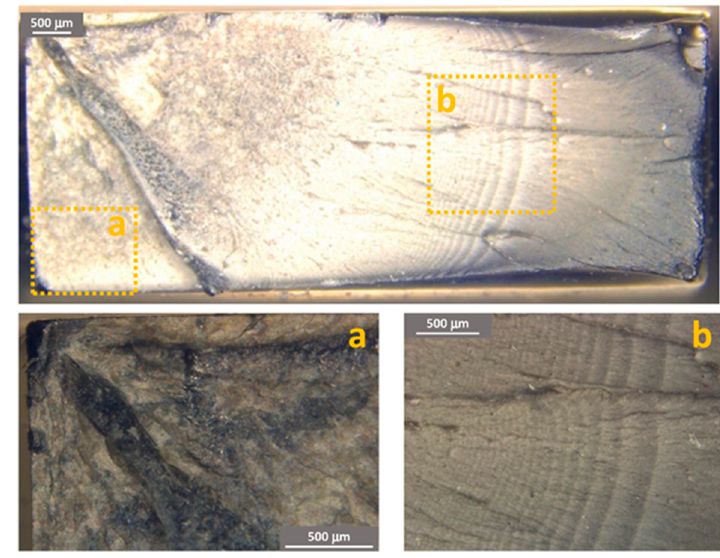
Figure 12. PC-ABS fracture surface after test at 85 °C. ( a ) Crack initiation point; ( b ) propagation beach marks.